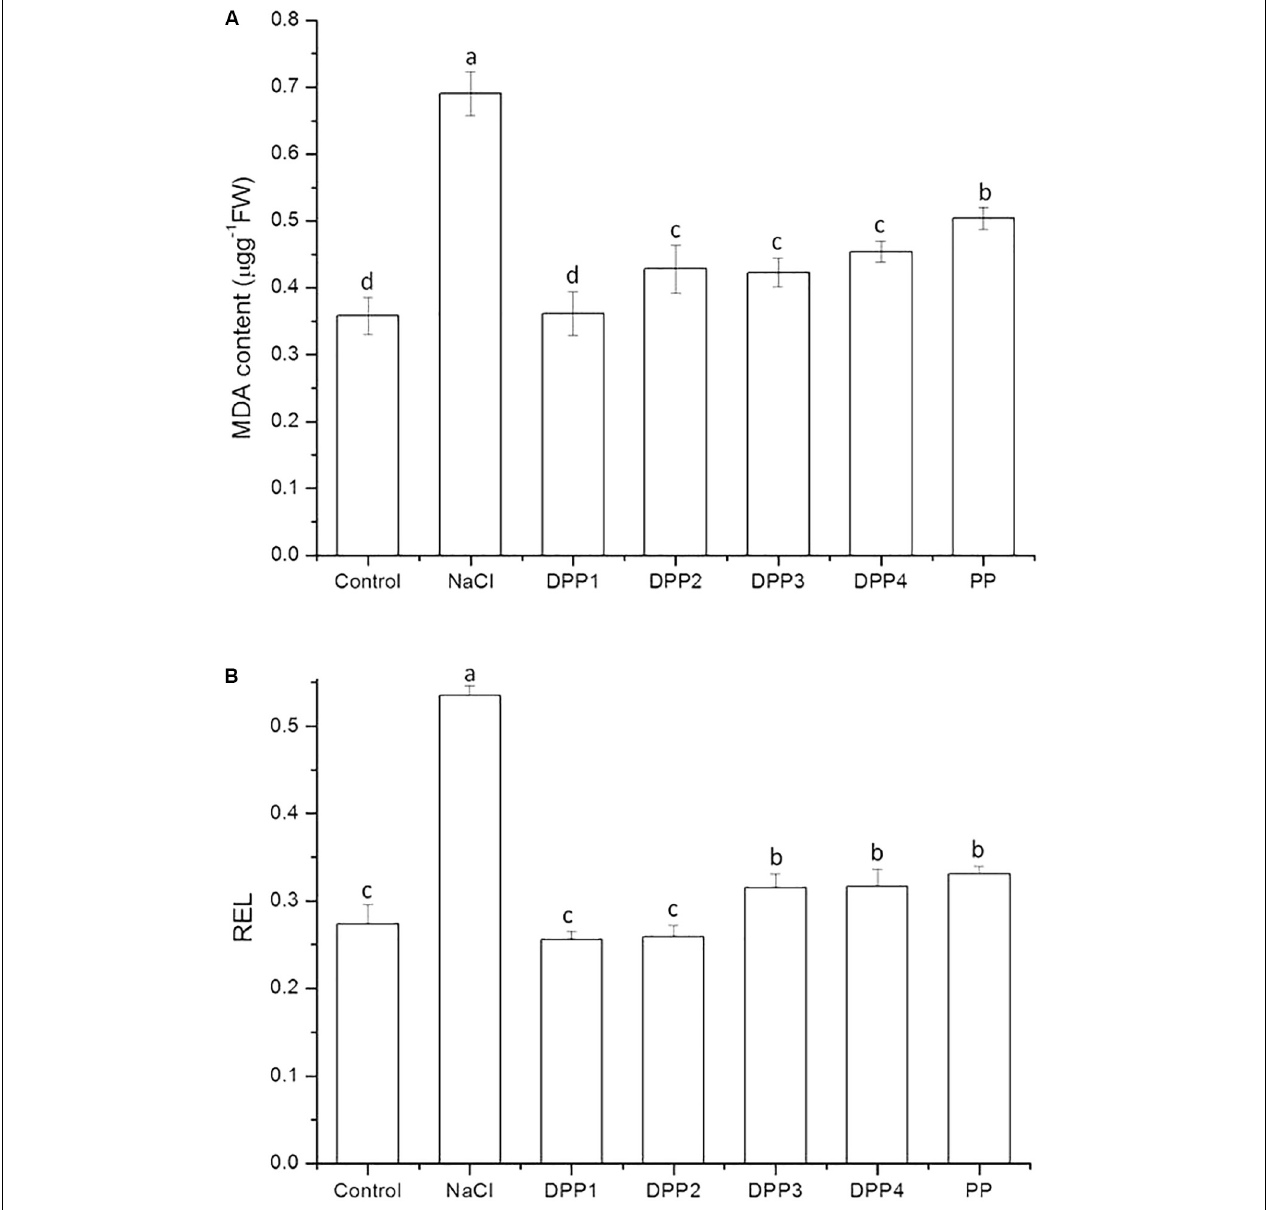
FIGURE 2 | Effect of four degraded (DPP1,2,3,4) and natural polysaccharides (PP) from P. yezoensis on MDA content (A) and REL (B) in leaves of Jimai-22. Values are the mean ± SD of three replicates. Different letters indicate significant differences at P <